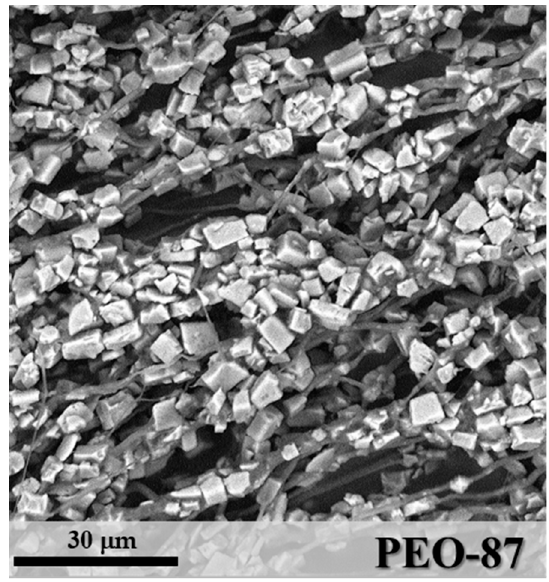
Figure 6. SEM image of PEO-87.